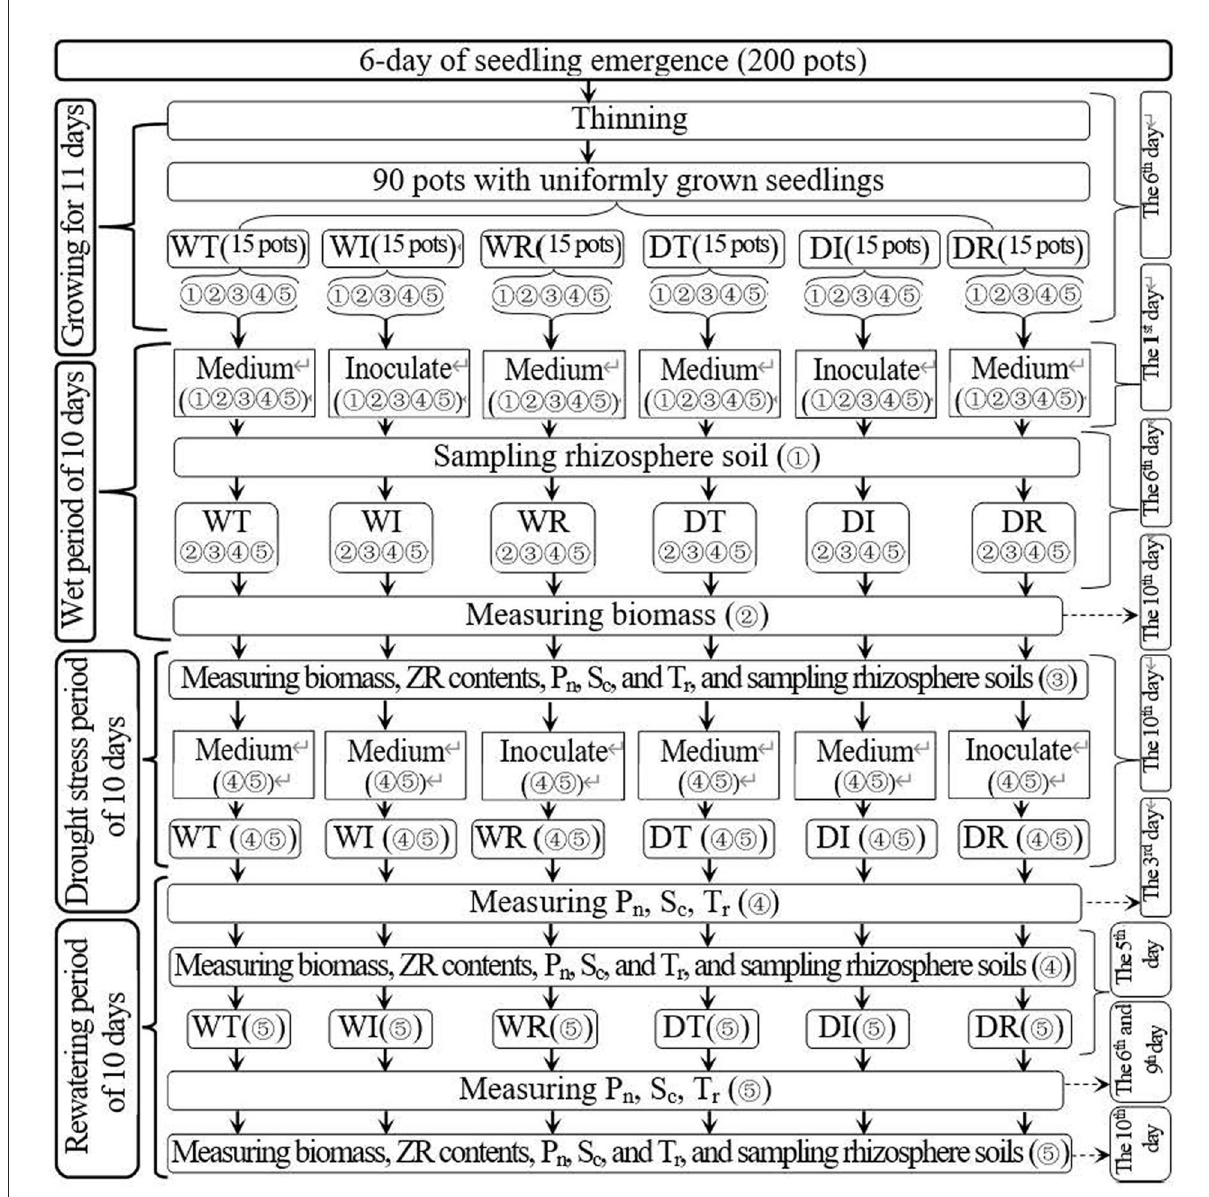
FIGURE1 Schematic diagram for the experimental design. WT, WI, WR, DT, DI, and DR indicate treatments of wetness, wetness with AOB strain inoculation during wet period, wetness with AOB strain inoculation during rewatering period, post-drought rewatering, post-drought rewatering with AOB strain inoculation during wet period, post-drought rewatering with AOB strain inoculation during rewatering period, respectively. “ ‹ ”, “ › ”, “ fi ”, “ fl ”, and “ (cid:176) ” show the first, second, third, fourth, and fifth subgroups of each treatment, respectively. Pn, Sc, and Tr represent the net photosynthetic rate, stomatal conductance, and transpiration rate, respectively. “Inoculate” and “Medium” represent adding AOB stain solution and liquid medium without AOB, respectively.